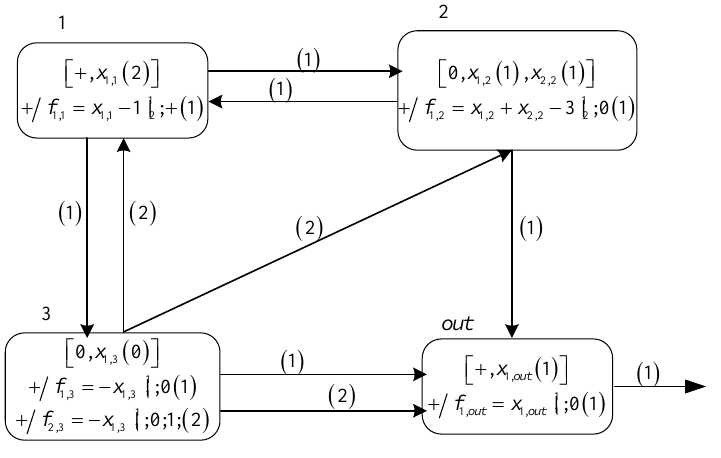
. Figure 1. An example NSNVC P system Π ex ex